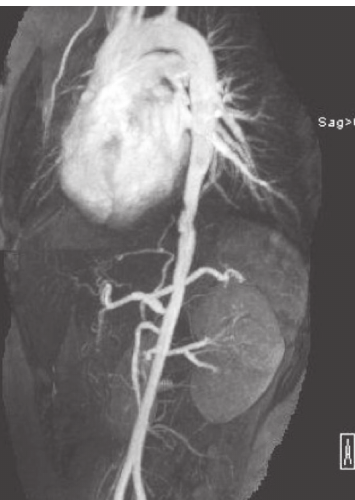
Figure 1: Magnetic resonance angiogram of chest and abdomen: severe irregularity and narrowing of the descending thoracic aorta. The subclavian arteries were not visualized in their entirety bilaterally during the initial imaging.